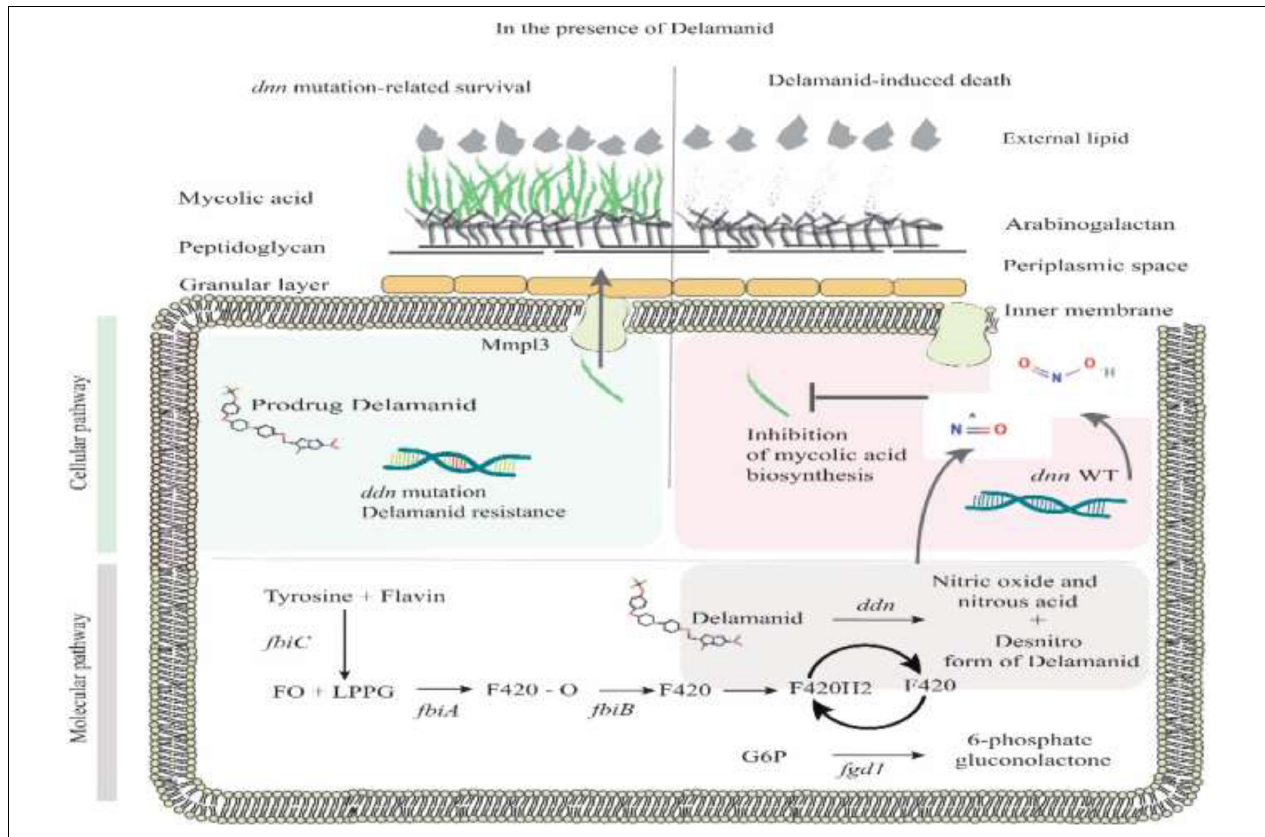
FIGURE 2 | Mechanism of delamanid